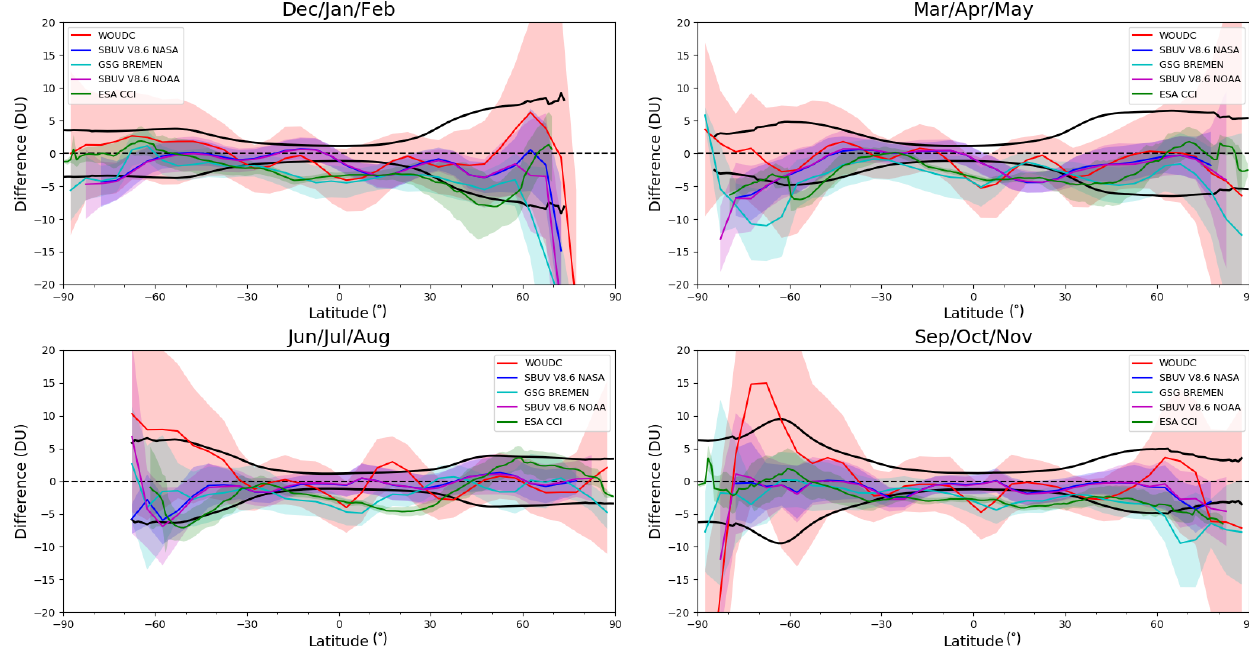
Figure 7. TCO differences (NIWA-BS TCO minus validation database) as a function of latitude plotted as seasonal means over the entire period of data available. The 1 σ uncertainty range in the NIWA-BS TCO is shown in black and the standard deviation on the differences between NIWA-BS TCO and each validation database is shown by the shading.